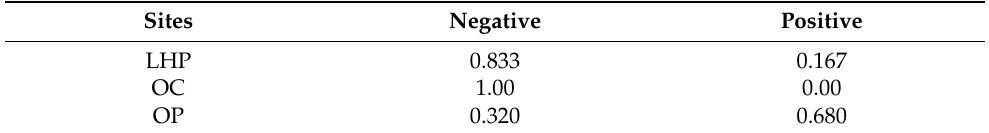
Table 3. Conditional probability of HPV (human papilloma virus) status given the tumor site